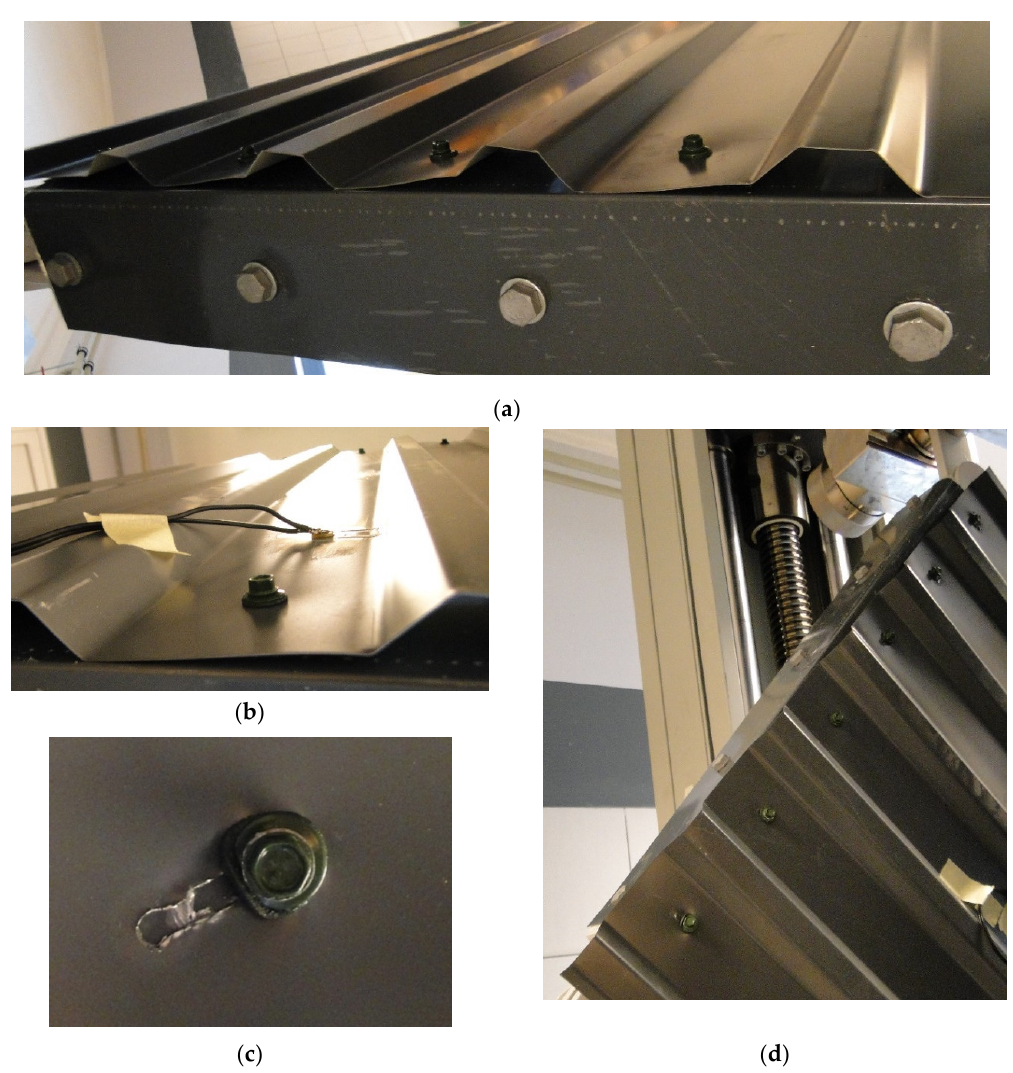
Figure 10. Deflections of trapezoidal sheeting observed during laboratory tests: ( a ) profile distortion—global view; ( b ) profile distortion—local view; ( c ) hole elongation; ( d ) rotation of the sheeting due to hole elongation.